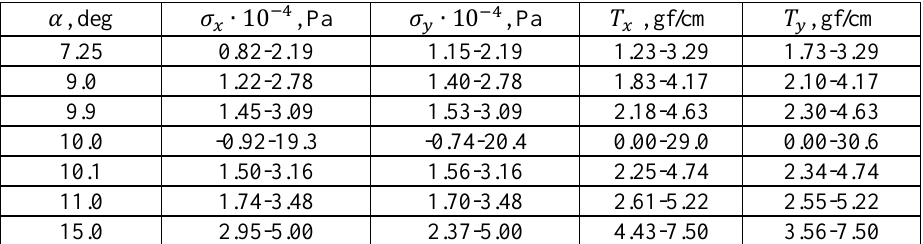
Table 3. Stressed state of the mesh fabric under the different characteristics of